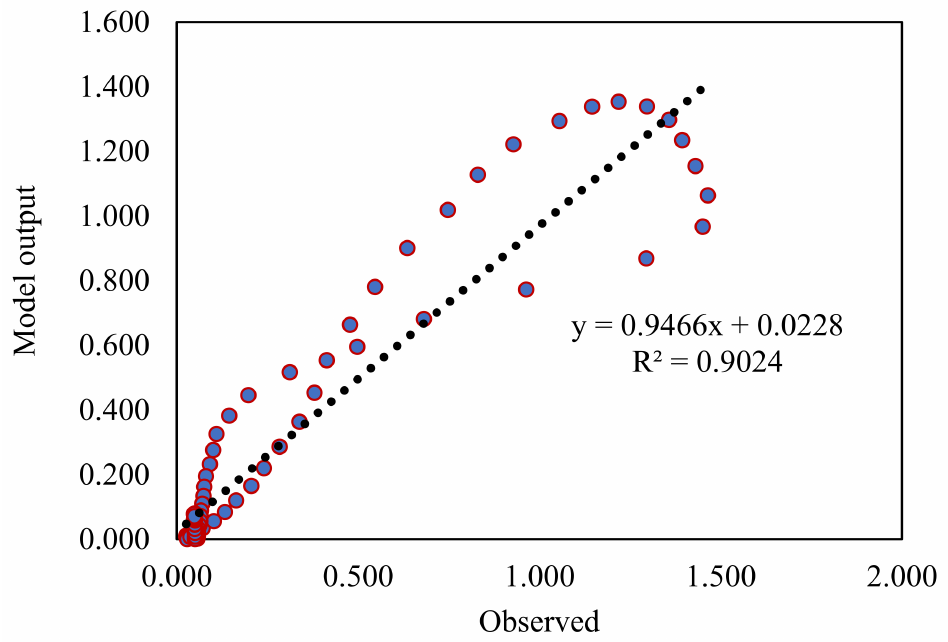
Figure 12. Crossplot of model output and observation for the instantaneous gas injection case.